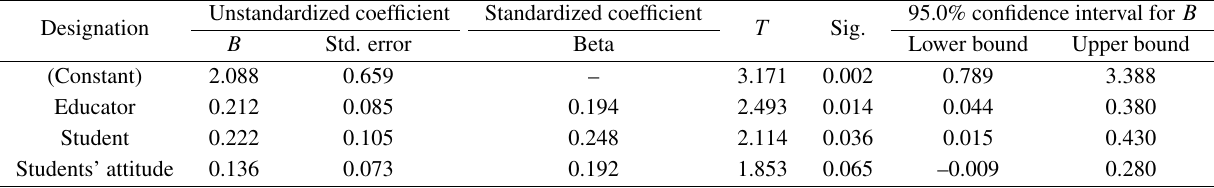
Table 6 Coefficient of parameters to evaluate the